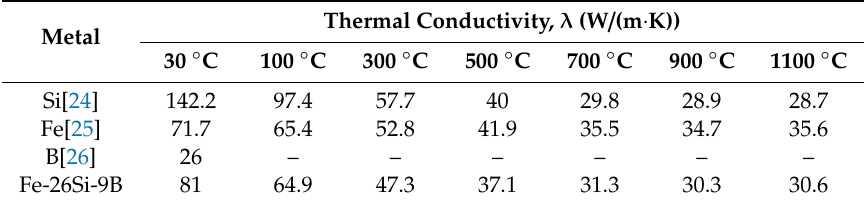
Table 1. The thermal conductivity of the pure metal and its relative eutectic alloys.